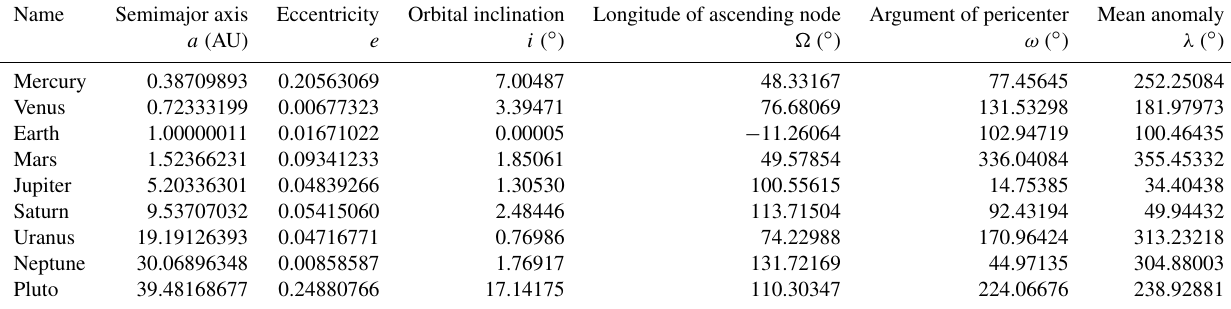
Table 1. Orbital elements of planets in the solar system and the dwarf planet Pluto.(January 2000). Name Semimajor axis Eccentricity Orbital inclination Longitude of ascending node Argument of pericenter Mean